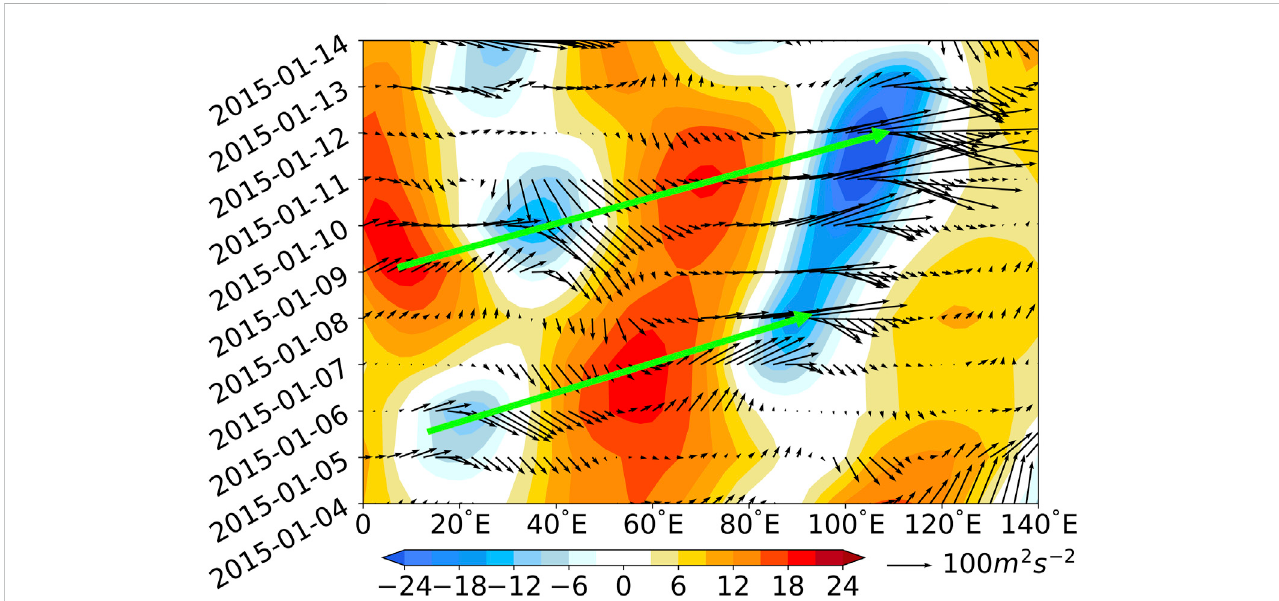
FIGURE 10 Time – longitude pro fi le of the geopotential height anomalies (shading; units: 10 gpm) and the wave activity fl ux (vectors; units: m 2 · s − 2 ) at 250 hPa along the axis of the jet stream at 25 ° N on January 4 – 14, 2015. The green arrow shows the propagation of the wave